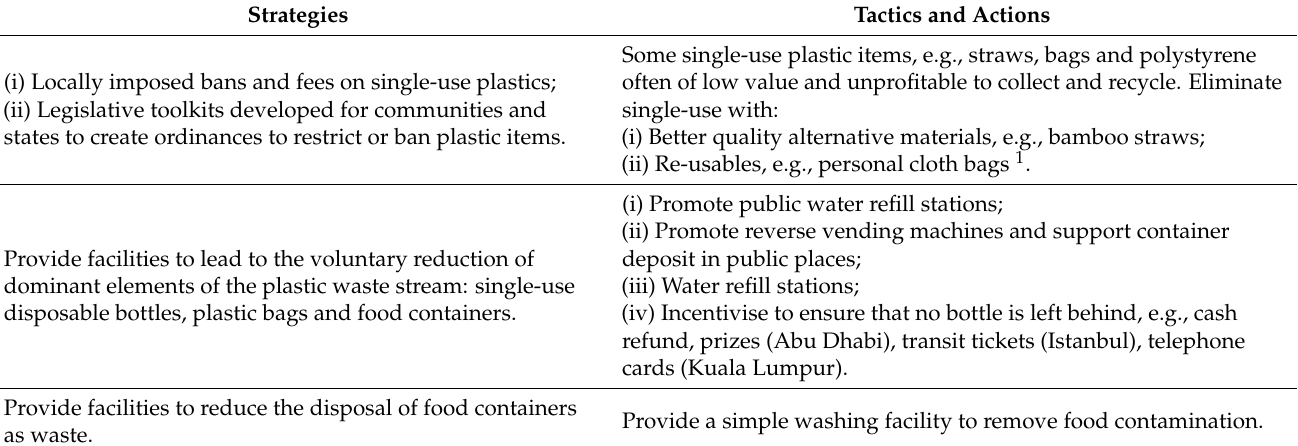
Table 1. Strategies and tactics for reducing plastic pollution. Strategies Tactics and